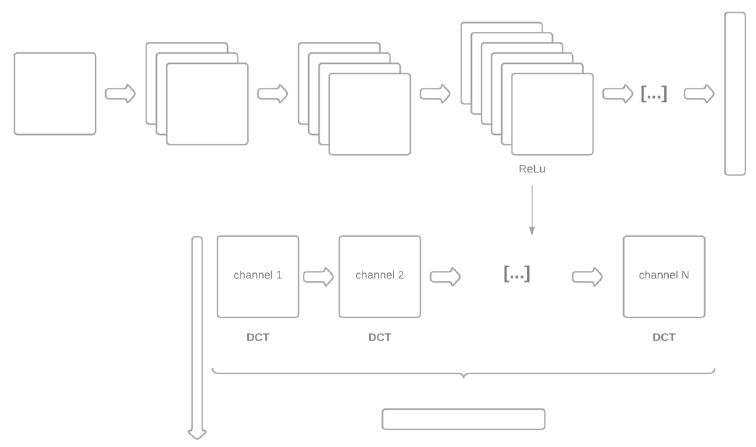
Figure 3. Schematic of